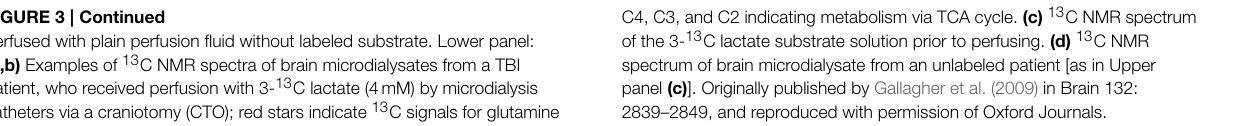
C4, C3, and C2 indicating metabolism via TCA cycle. (c) 13 C NMR spectrum of the 3- 13 C lactate substrate solution prior to perfusing. (d) 13 C NMR spectrum of brain microdialysate from an unlabeled patient [as in Upper panel (c) ]. Originally published by Gallagher et al. (2009) in Brain 132: 2839–2849, and reproduced with permission of Oxford Journals.